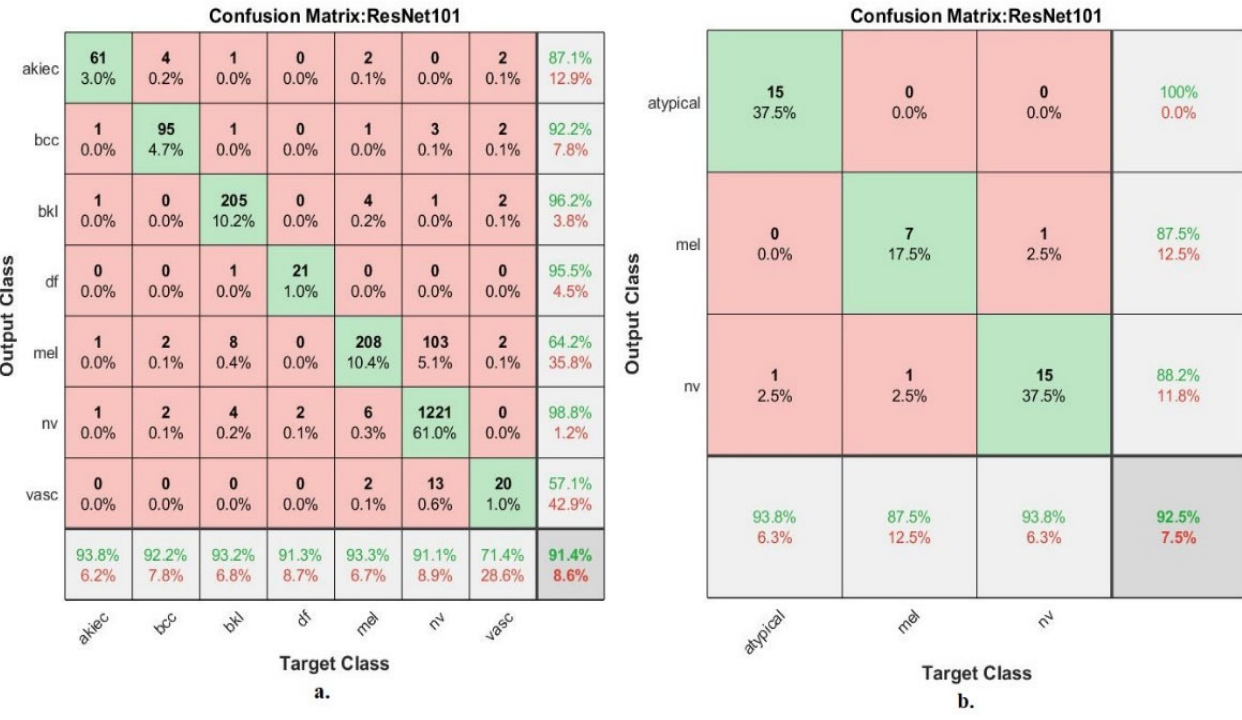
Figure 10. Confusion matrix for the classification of two skin lesion datasets by the ResNet101 model through datasets of ( a ) HAM10000 and ( b ) PH2.